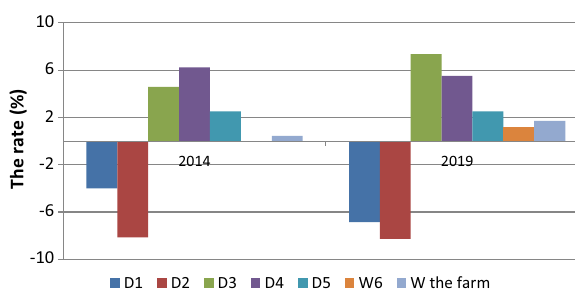
Fig. 5 The rate of change in pH between 2014 and 2019